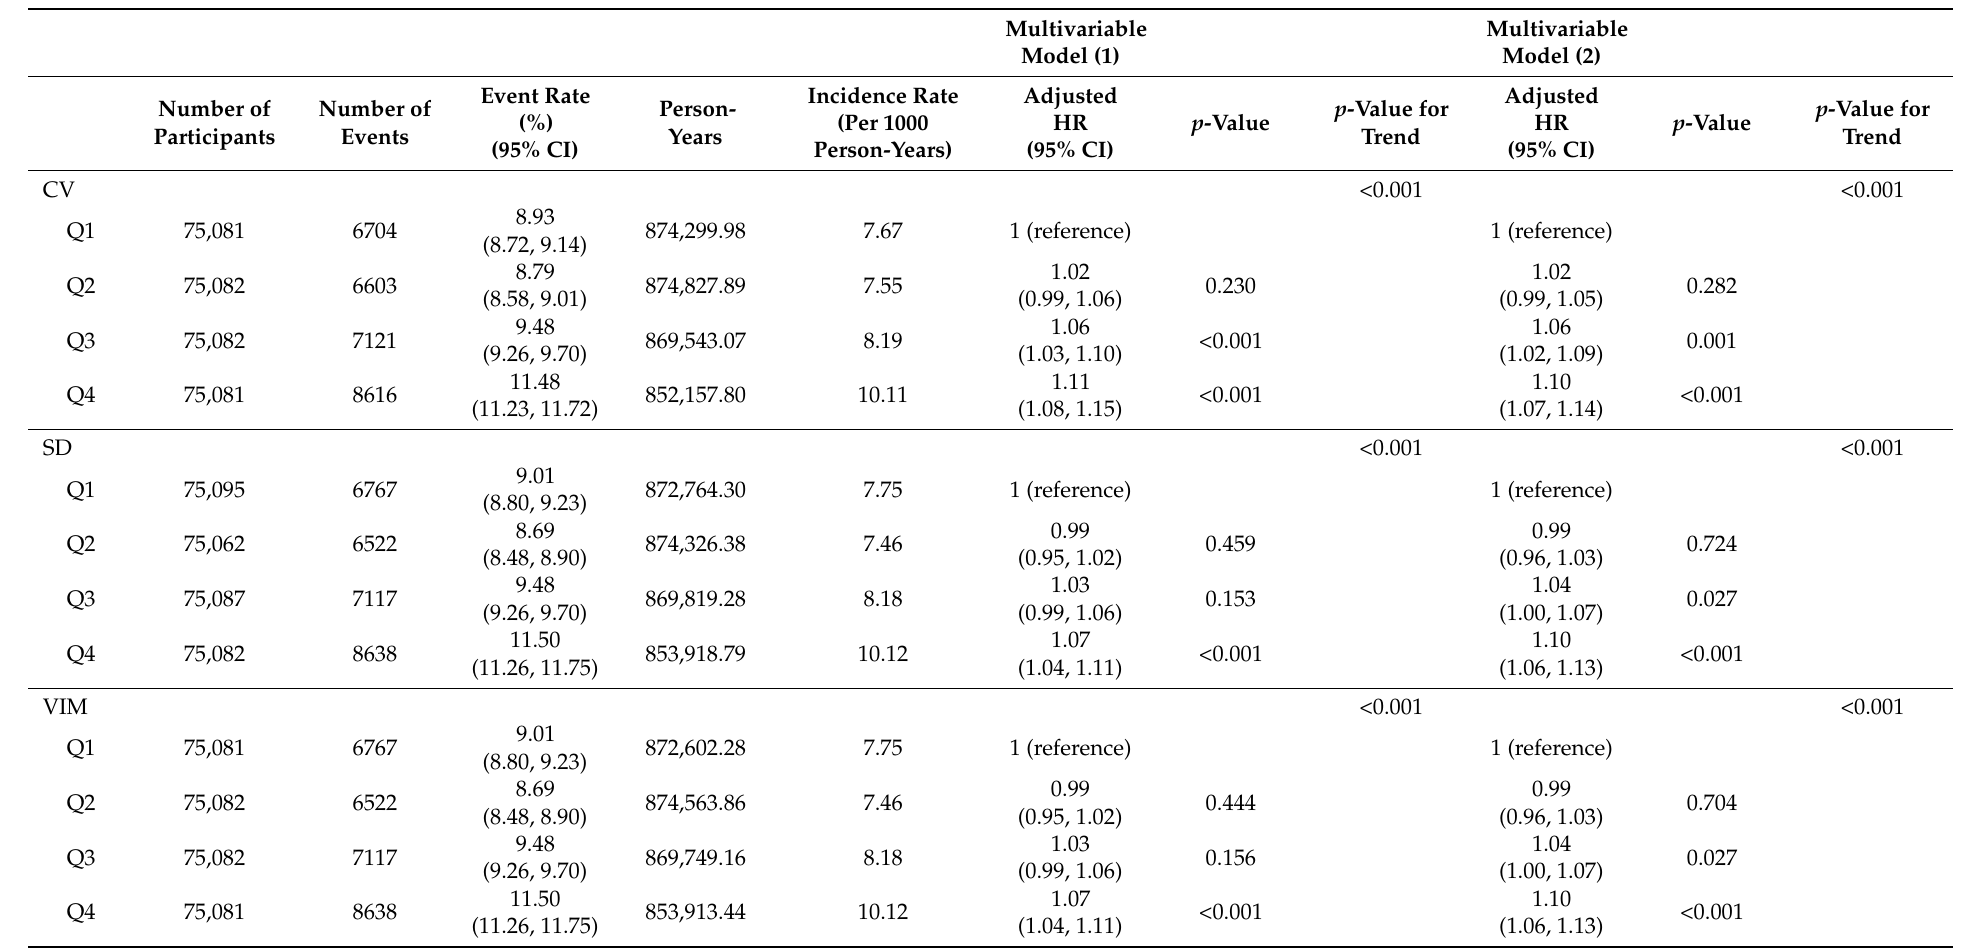
Table 2. The risk for the occurrence of osteoporotic fractures according to the quartiles of total cholesterol variability.